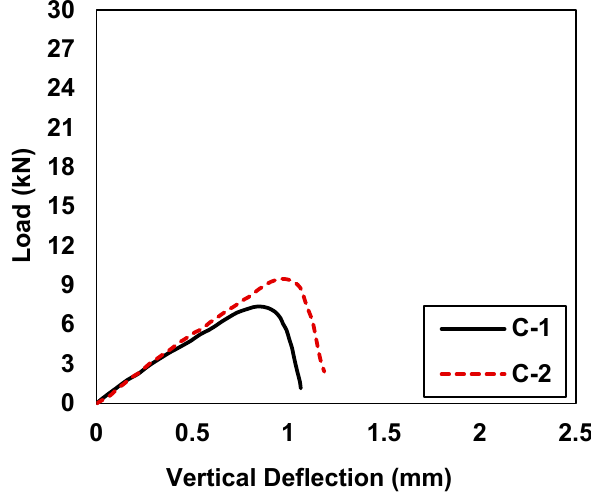
Figure 5. Load vs. midspan deflection for control samples (C-1 and C-2).